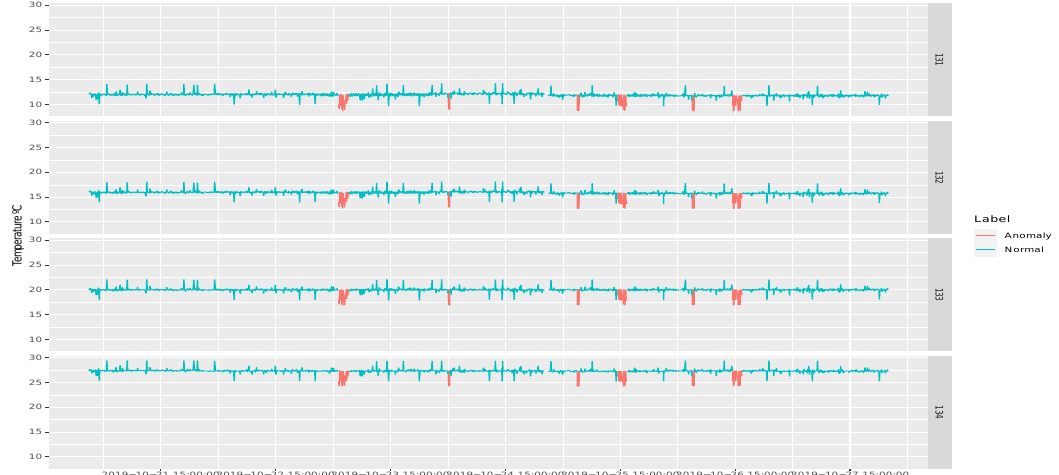
Figure 8. InRow 13 sensor signals.